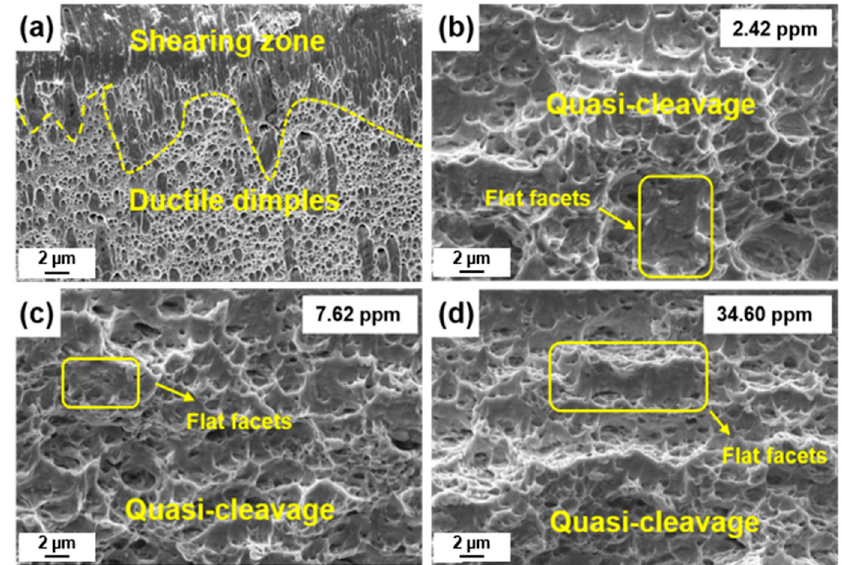
Figure 9. Fracture surfaces at the edge region of AUS + ART annealed specimens experienced slow strain rate tensile. ( a ) No H-charged state; ( b ) H-charged for 2 h with 2.42 ppm; ( c ) H-charged for 8 h with 7.62 ppm. ( d ) H-charged for 24 h with 34.60 ppm.